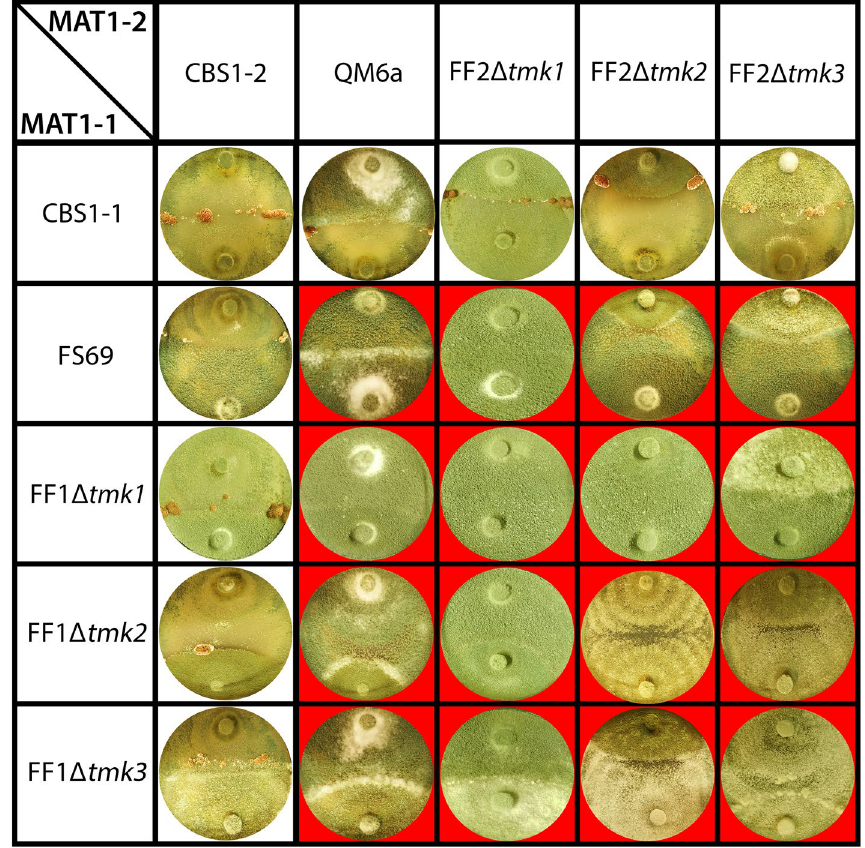
Figure 4. Involvement of MAPkinases in mating abilities. Sexual development of backcrossed MAPkinase mutant strains after 14 days grown in light cycles (12 h light, 12 h darkness) at 22 °C.